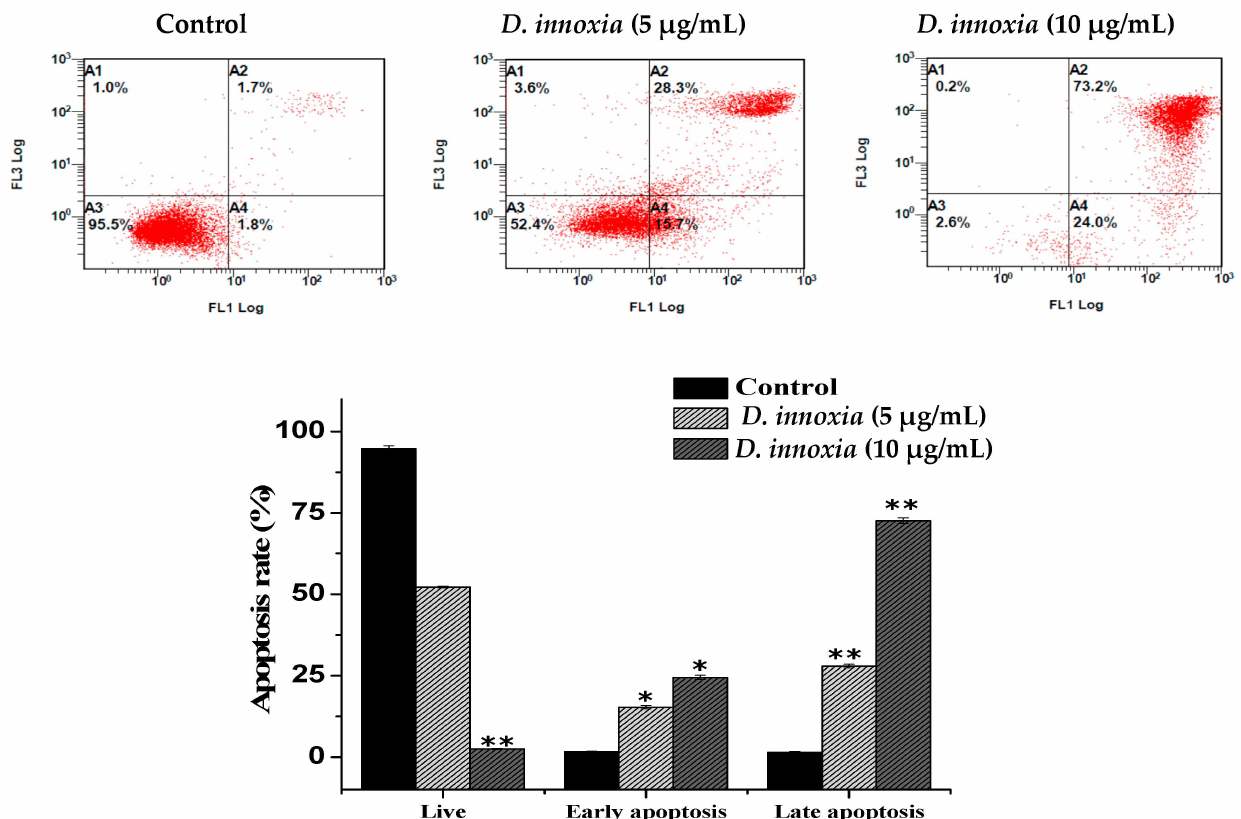
Figure 3. Dot plots of Annexin V-FITC stained LoVo cells after 48 h exposure to 5 and 10 µ g/mL of D. innoxia . (A3: Annexin V-negative; PI-negative), early apoptotic cells (A4: Annexin V-positive; PI-negative), late apoptotic cells (A2: Annexin V-positive; PI-positive) and necrotic cells (A1: Annexin V-negative; PI-positive). A minimum of 20,000 events were read (n = 3). (One representative for 3 individual experiments, each performed in triplicate). Data are presented as means ± SD and the difference was statistically significant at (* p < 0.05, ** p <